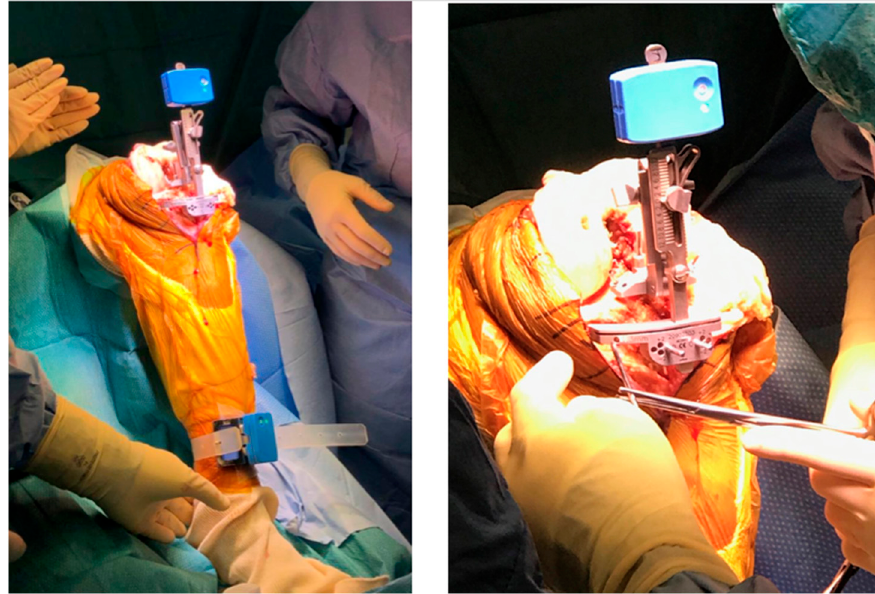
Figure 2. Cutting guide adjustment, before guide fixation then tibial cut.